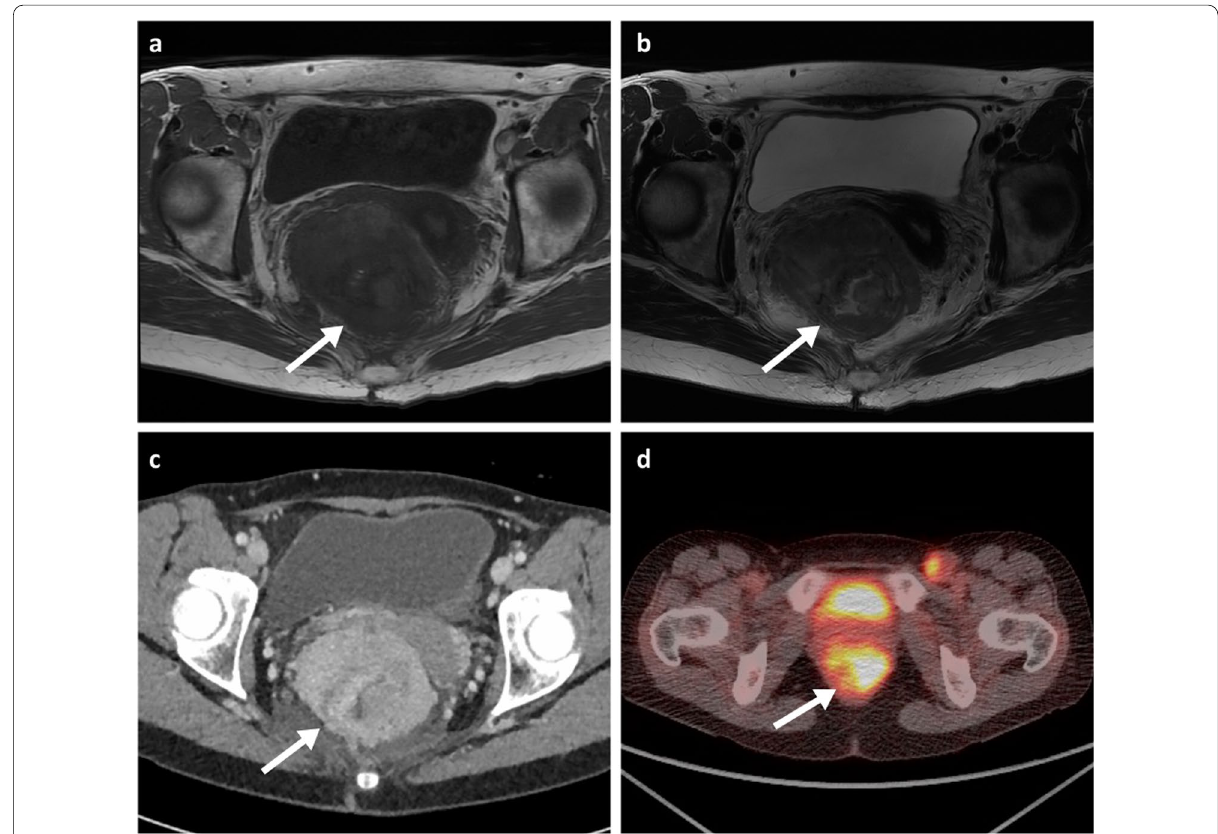
Fig. 14 MRI T1WI and T2WI axial ( a , b ), portal phase contrast-enhanced CT axial ( c ) and PET-CT axial (obtained two months prior to the shown MRI and CT) ( d ) of a 57-year-old female patient with a large metastatic melanoma anorectal mass (arrows). The mass demonstrates internal foci of higher T1 signal. PET uptake is also seen within a left inguinal